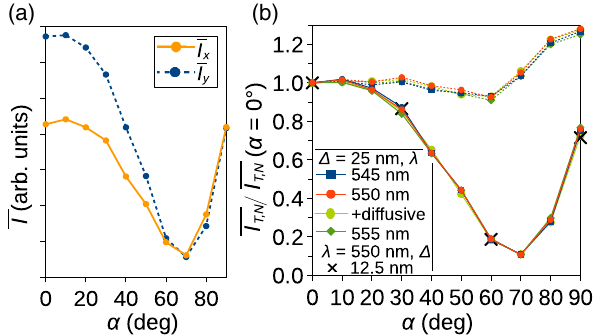
FIG. 18. Simulated transmitted light intensity for different simulation parameters. Bundle of densely grown fibers [cf. Fig. 3(a)] simulated for different inclination angles α : (a) Mean transmitted light intensity for light polarized along the x axis ( I ) x or along the y axis ( I ) plotted against α . The simulations are y performed for a numerical aperture NA ¼ 0 . 15 using a normally incident plane wave with 550 nm wavelength and simulation parameters specified in Table II. (b) Transmittance curves (mean transmittance value I plotted against α ) obtained from 3D-PLI T;N simulations for normally incident light with different wavelengths λ ¼ f 545 ; 550 ; 555 g nm and a Yee mesh size of Δ ¼ 25 nm. The simulations for λ ¼ 550 nm are also performed for diffusive light (with angles of incidence f θ ¼ 0 ° g , f θ ¼ 3 °; φ ¼ 4 × 90 ° g ). The curves are normalized by the mean transmittance value of the horizontal bundle, respectively. The solid curves are computed for the numerical aperture of the imaging system (NA ¼ 0 . 15 ), and the dashed curves are computed for NA ¼ 1 . The black crosses belong to simulations with NA ¼ 0 . 15 , λ ¼ 550 nm, and Δ ¼ 12 . 5